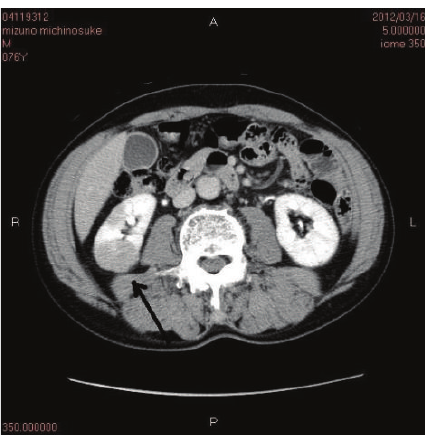
Figure 1: Enhanced CT findings. The right kidney (arrow) shows irregular enhancement compared to the left kidney. The findings suggest renal pelvic carcinoma.